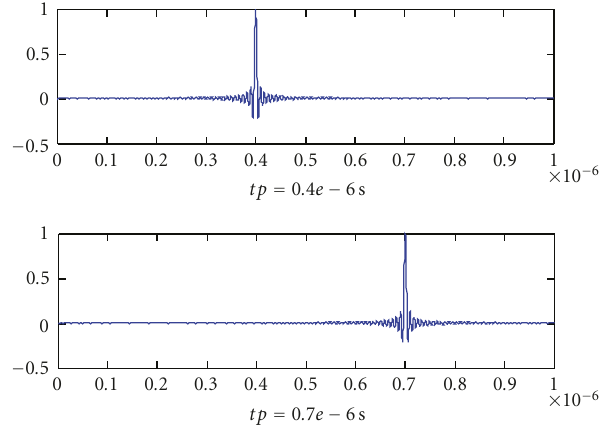
Figure 4: Receiving signal waveform corresponding to di ff erent distance after initial phase adjustment.